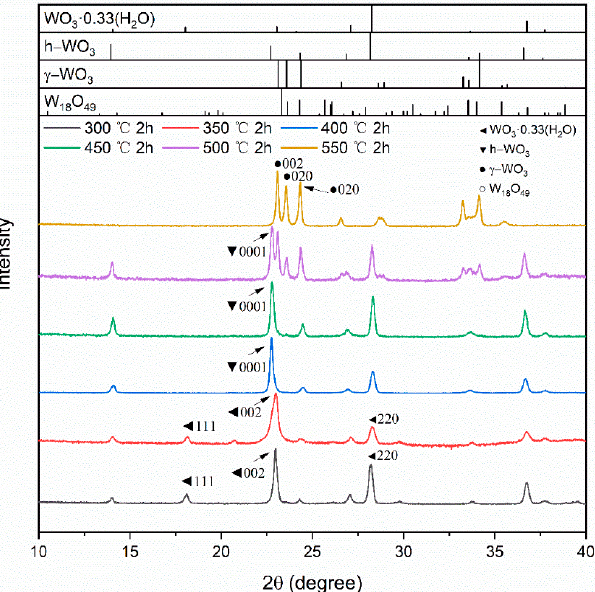
Figure 10. XRD spectra of samples that are annealed at temperature of 300 ◦ C, 350 ◦ C, 400 ◦ C, 450 ◦ C, 500 ◦ C, and 550 ◦ C for 2 h. The starting material is sample no. 3, which only consists of WO 3 · 0.33(H 2 O). The top inset is the standard reference diffraction patterns of W 18 O 49 (JCPDS no. 36-0101), h-WO 3 (JCPDS no. 75-2187), WO 3 · 0.33(H 2 O) (JCPDS no. 87-1203), and γ -WO 3 (JCPDS no. 32-1295).